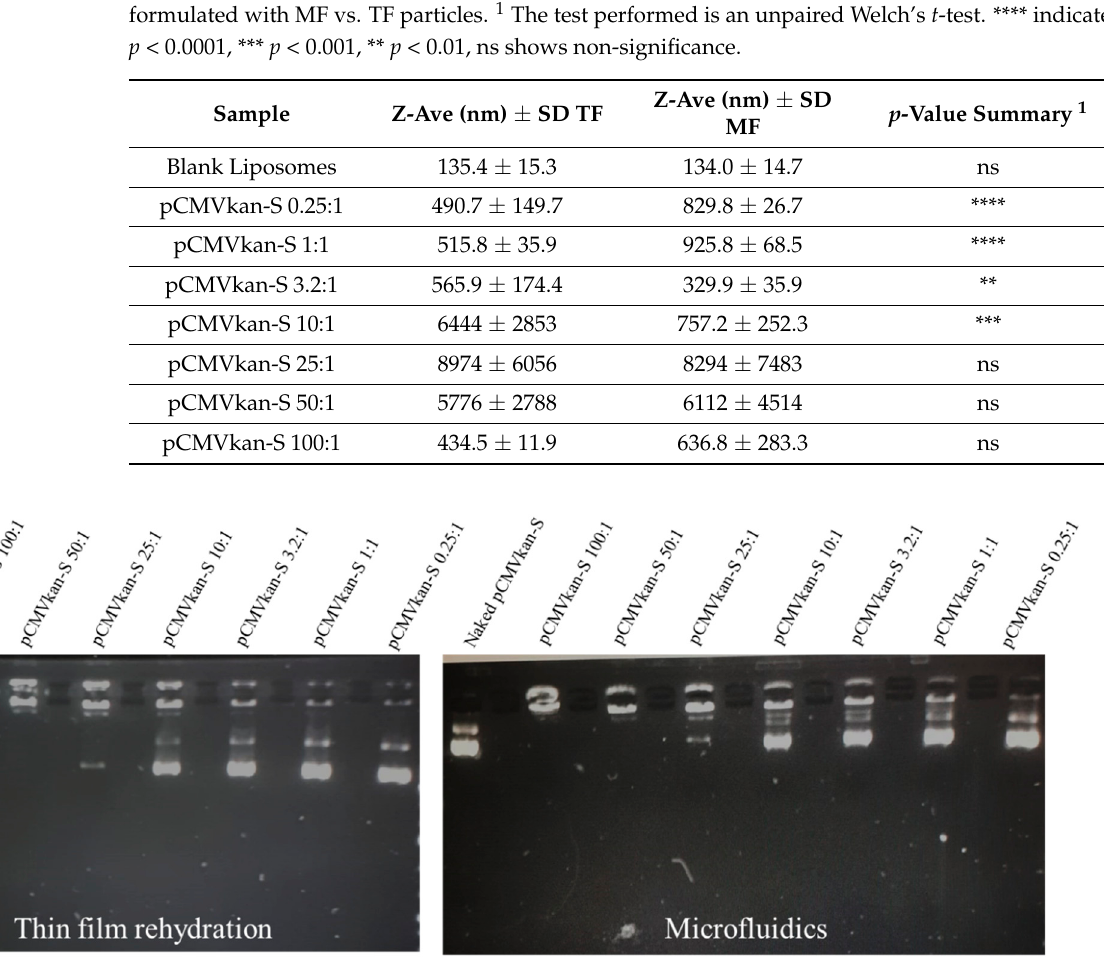
Figure 6. Agarose gel electrophoresis of naked pCMVkan-S in PBS or different N/P of DOTAP4/pCMVkan-S complex is shown. Image on the left and right show the results obtained from TF- and MF-manufactured liposomes, respectively.